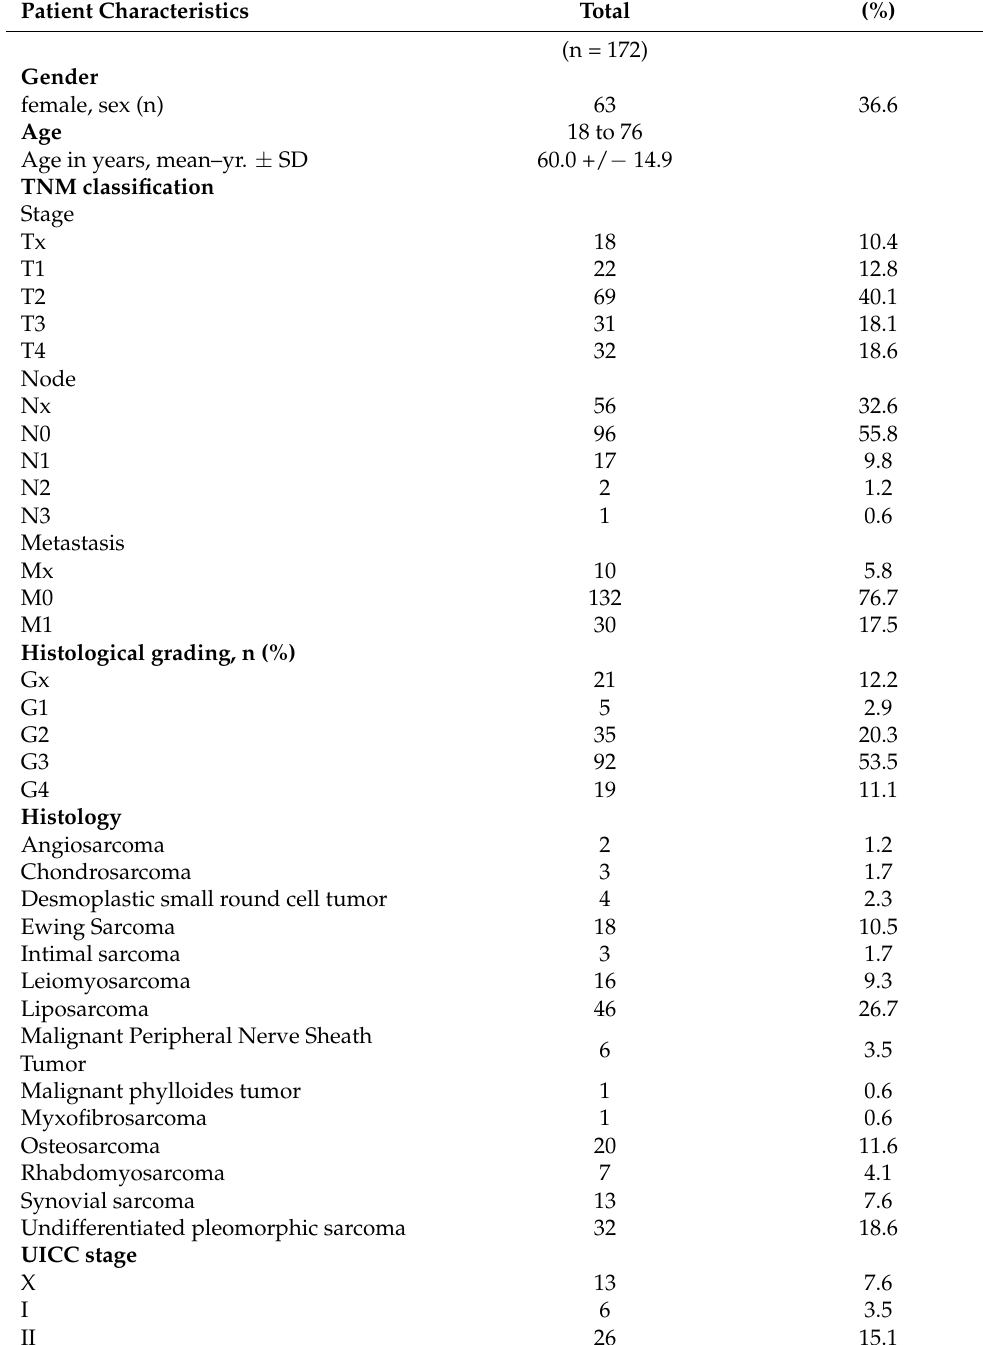
Table 1. Patient